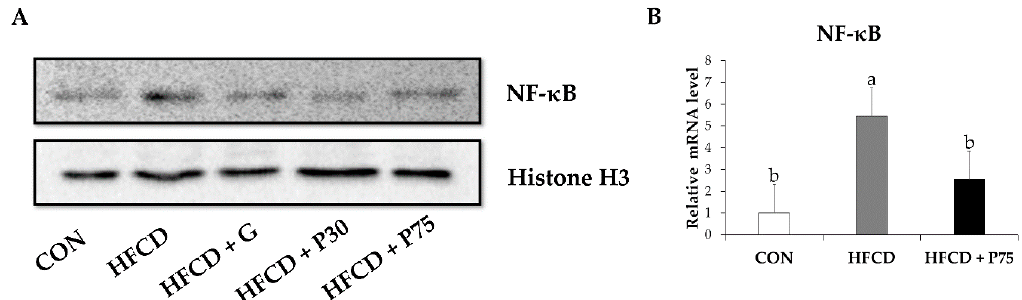
Figure 5. PEITC regulates inflammation-related genes in the livers of HFCD-fed mice: ( A ) Protein levels were measured by immunoblotting for nuclear factor-kappa B (NF- κ B). Equal loading of protein was ensured by stripping the immunoblot and reprobing for histone H3; ( B ) Evaluated mRNA levels of NF- κ B in mice liver. Values were analyzed by the 2 − ∆∆ CT method. Significance was determined by comparison with β -actin normalized 2 − ∆∆ CT values. Data represent the means ± standard deviation (SD, n = 3, degrees of freedom = 2), and di ff erent letters indicate significant di ff erences ( p < 0.05, a > b), as determined using Duncan’s multiple range test. CON: AIN-93G diet, HFCD: 60% calories from fat